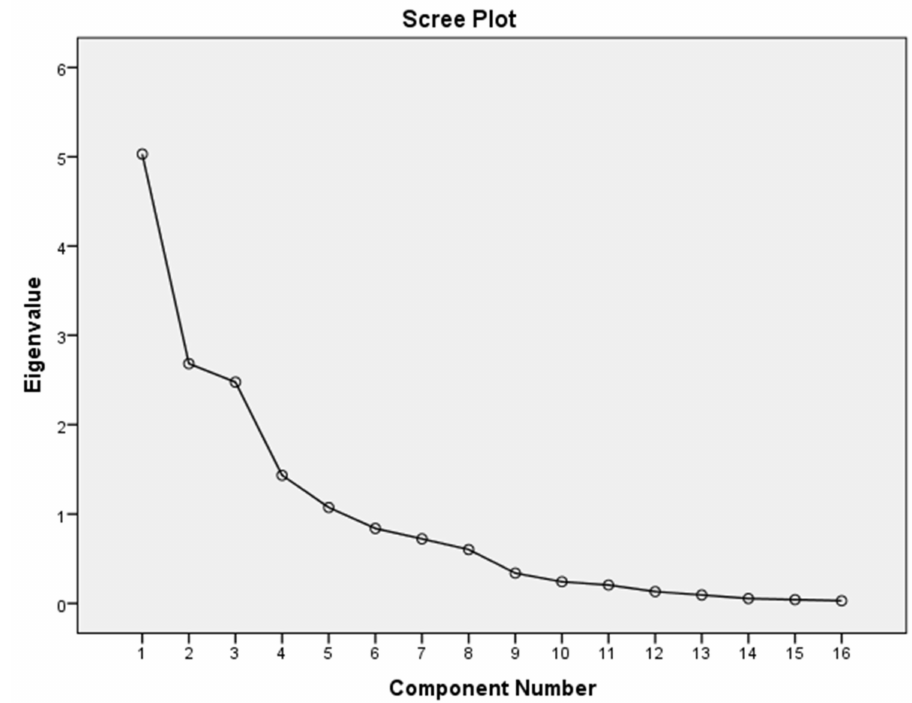
Figure 1. Scree plot. Own analysis. Extraction method: principal component analysis. Rotation method: varimax with Kaiser